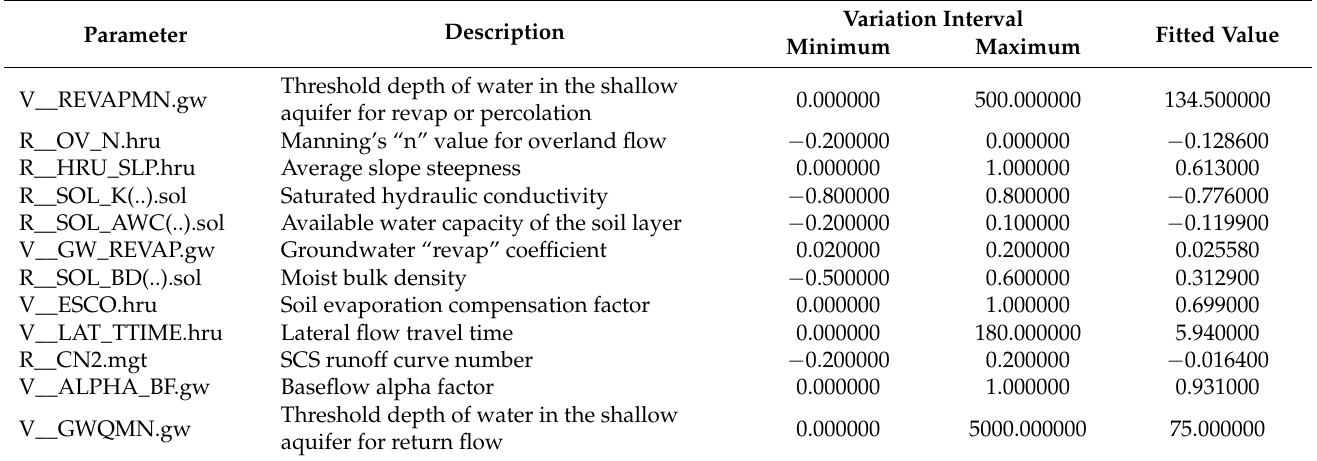
Table 2. Parameters used in the calibration.